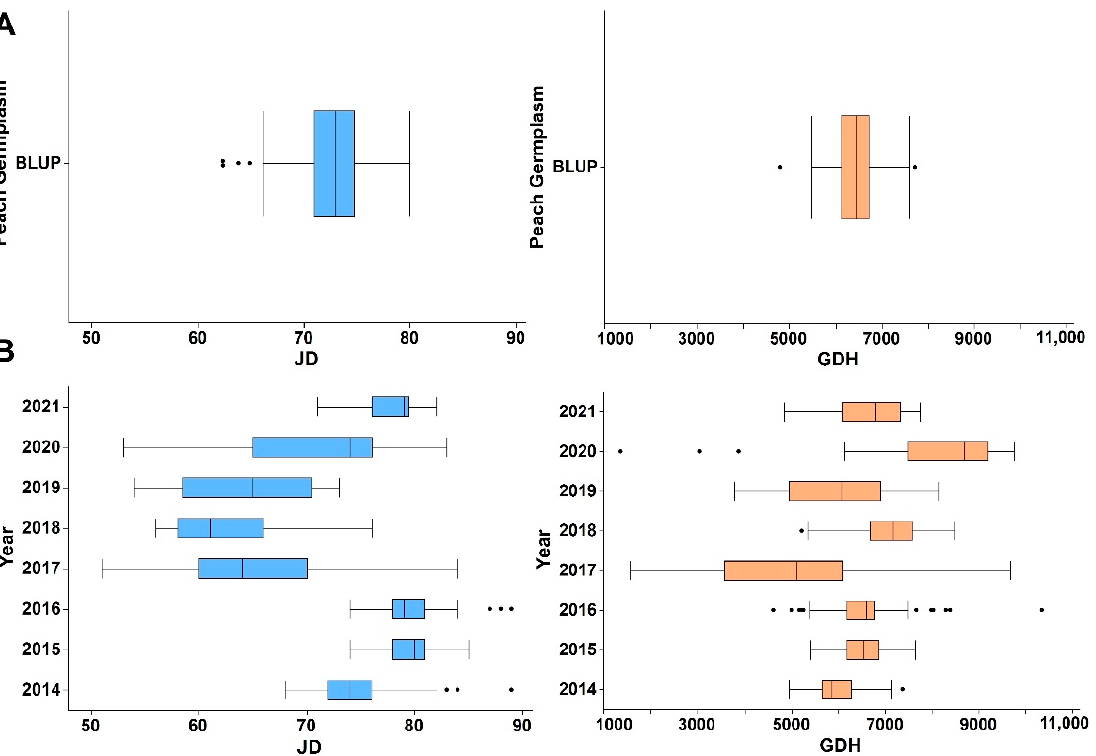
Figure 1. Bloom date (blue), expressed in Julian days (JD), and heat requirement (orange), expressed in growing degree hours (GDH), in the U.S. peach germplasm across eight years (2014–2021). Best Linear Unbiased Prediction (BLUP) values ( A ) and annual ( B ) data were calculated using standard base temperature of 4.5 ◦ C. The bold line within the boxplot indicates the median value. The whiskers designate variability outside the 25th and 75th percentile, respectively. Dots indicate outliers.